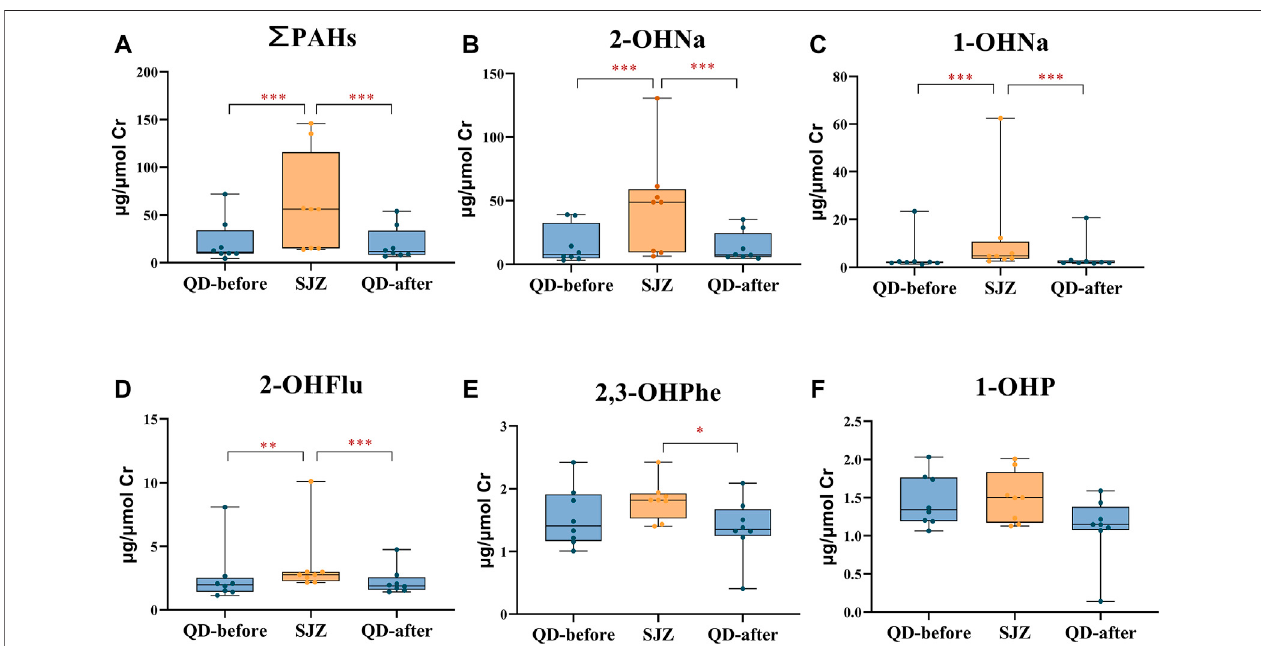
FIGURE2| Urinaryconcentrationsofpolycyclicaromatichydrocarbonmetabolitesin8participantsinthreeperiods.Yellowandbluesoliddotsrepresentsamplesfrom Shijiazhuang and Qingdao periods, horizontal lines in boxes represent the sample mean, and boxes represent the 25th – 75th percentiles. *False discovery rate < 5% after Benjamini – Hochberg adjustment. **False discovery rate < 1% after Benjamini – Hochberg adjustment. ***False discovery rate < 0.1% after Benjamini – Hochberg adjustment. (A-F) respectively represents the concentration of (cid:1) PAHs, 2-OHNA, 1-OHNA, 2-OH fl u, 2, 3-OHPHE and 1-OHP in the urine of participants in three periods.